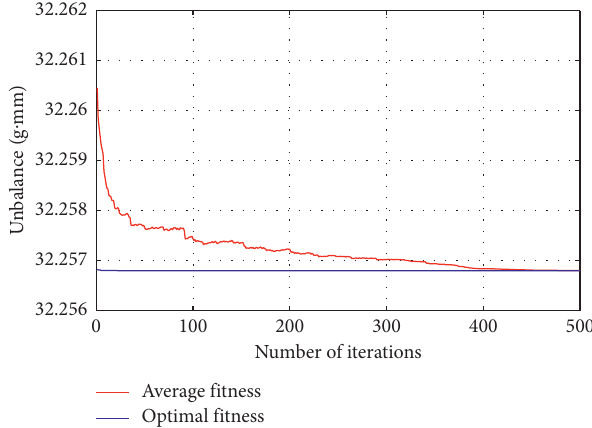
Figure 6: The convergence progress of the single-objective opti- mization for the